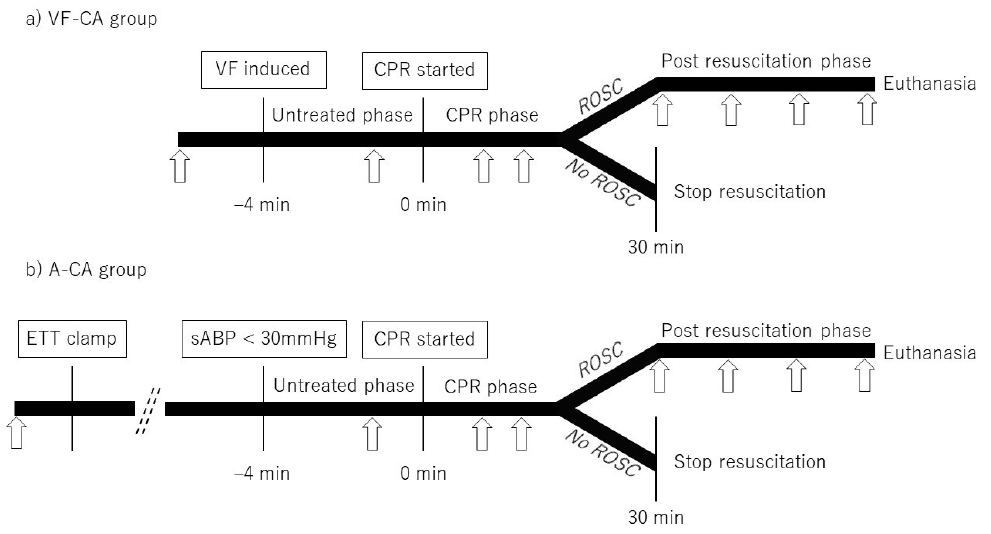
Figure 2. Experimental protocol. Arrows indicate the time points at which arterial blood gas was recorded (at baseline, − 1 min, and 3 min after CPR initiation and every 4 min thereafter; immediately after ROSC and every 20 min subsequently). VF-CA, ventricular fibrillation cardiac arrest; VF, ventricular fibrillation; CPR, cardiopulmonary resuscitation; ROSC, return of spontaneous circulation; A-CA, asphyxial cardiac arrest; ETT, endotracheal tube; sABP, systolic arterial blood pressure.